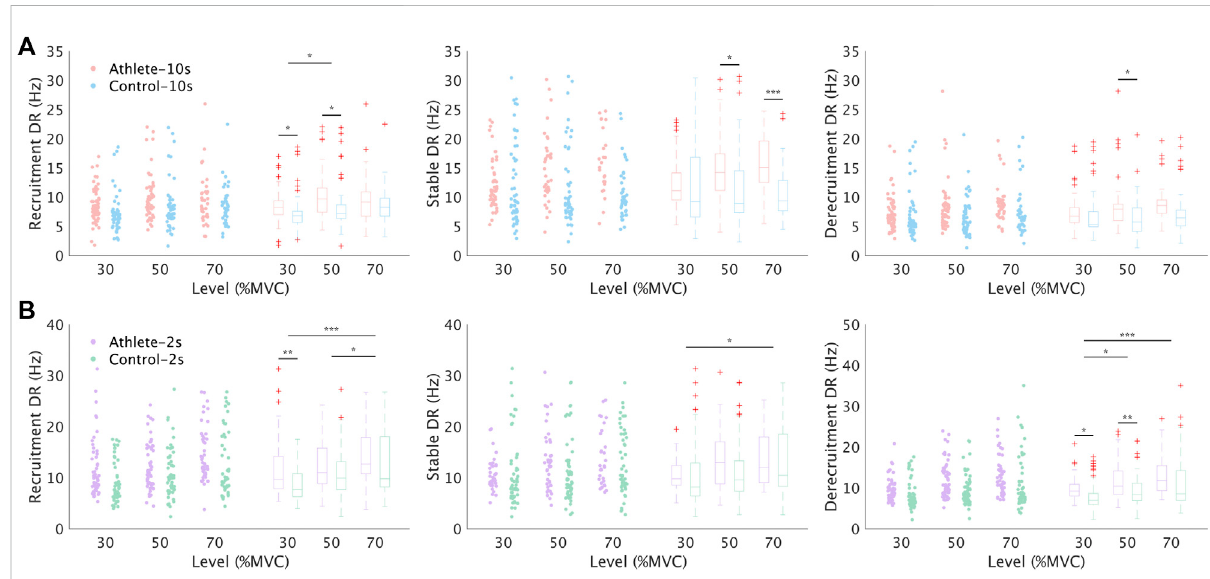
FIGURE 5 Comparison of MU discharge rate between Athlete and Control group. (A,B) illustrate the comparison results from session 1 and session 2, respectively. Only the common MUs, which were the same as in Figure 4, were analyzed in this fi gure. DR: discharge rate. The representation of symbols are the same as those in Figure